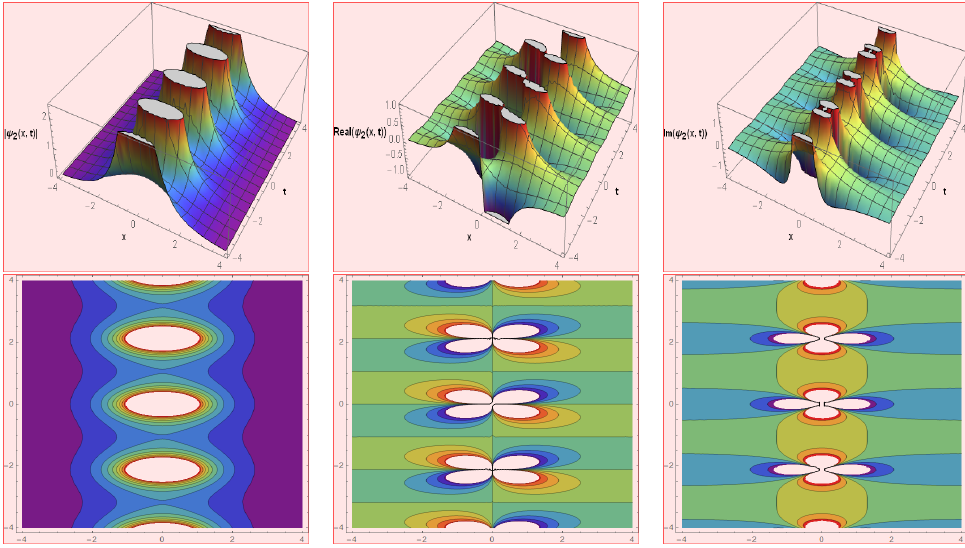
Figure 10. The absolute, real, and imaginary behavior in the shape of 3D and their corresponding contour plots are dispatched for ψ 2 ( x , t )